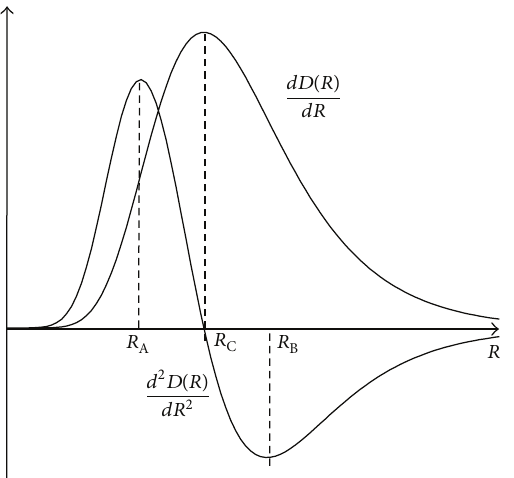
Figure 5: The first and second derivative curves of an 𝑅 - 𝐷 function.